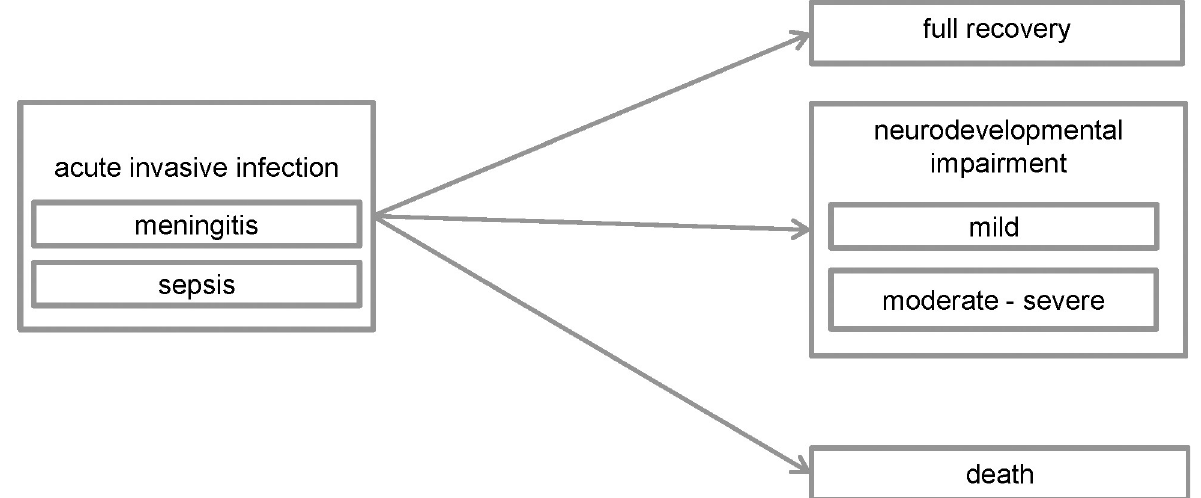
Fig 1. Structure of the neonatal invasive group B Streptococcus disease burden model.